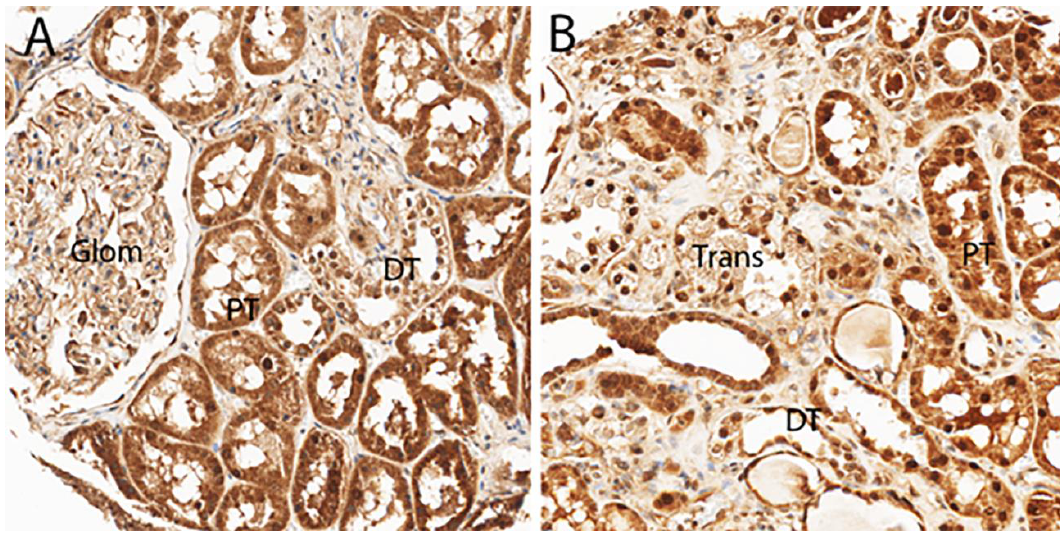
Figure 1. ICAD protein expression in normal kidney. In ( A ), expression was strong in the cytoplasm of the proximal tubular epithelium (PT) of normal kidney compared with distal tubular epithelium (DT) and glomerulus (glom). Nuclear expression is prominent in the distal tubule. In ( B ), there is a region that shows an apparent transition to clear cell RCC (trans), and within this region, nuclear localization of ICAD is intense, although cytoplasmic localization is still seen in the proximal tubular epithelium